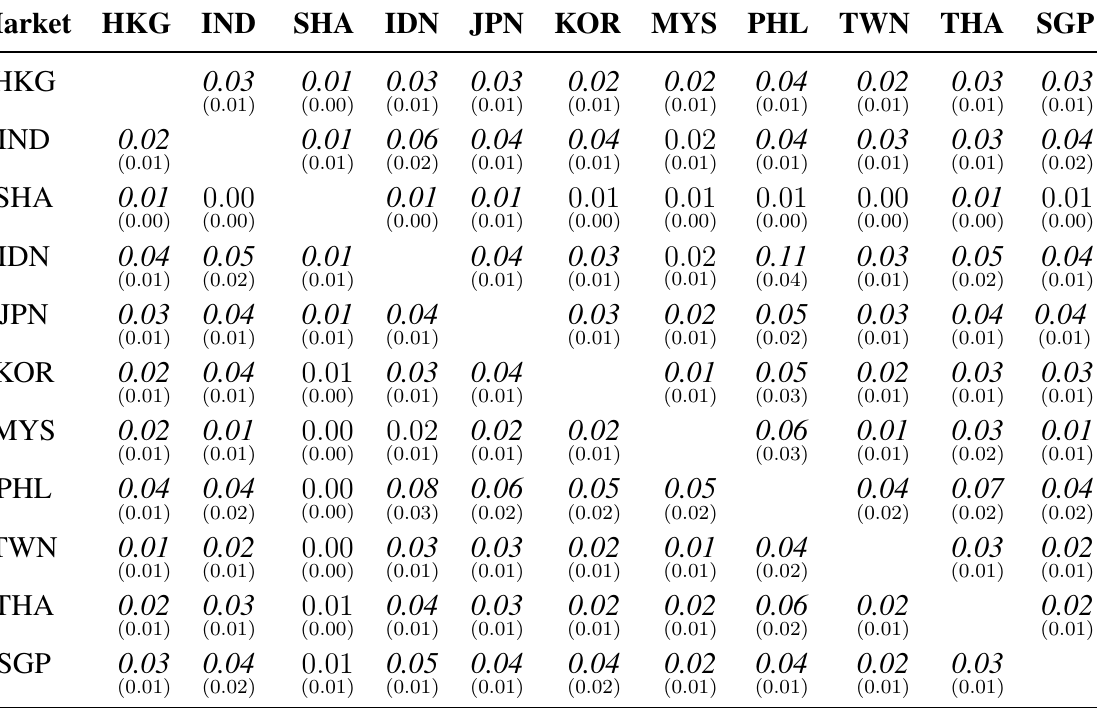
Table 13. Estimation results of ! 1 in the bivariate SV